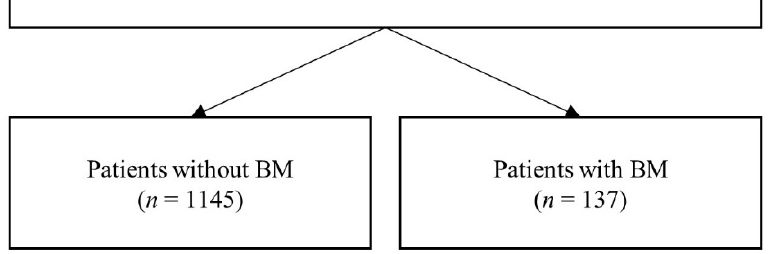
Figure 1. Patient selection flowchart.